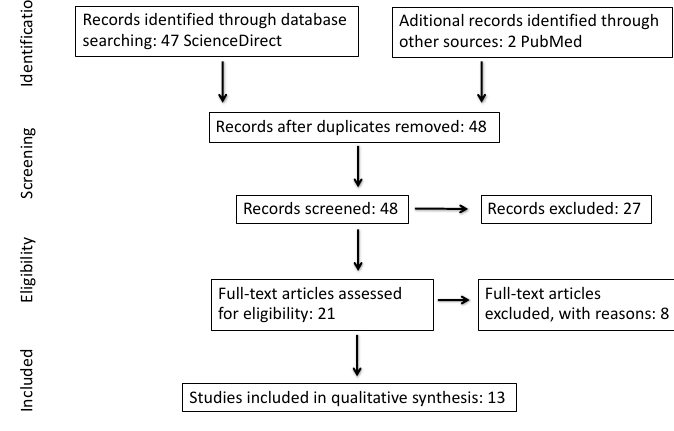
Figure 1. PRISMA flow chart.